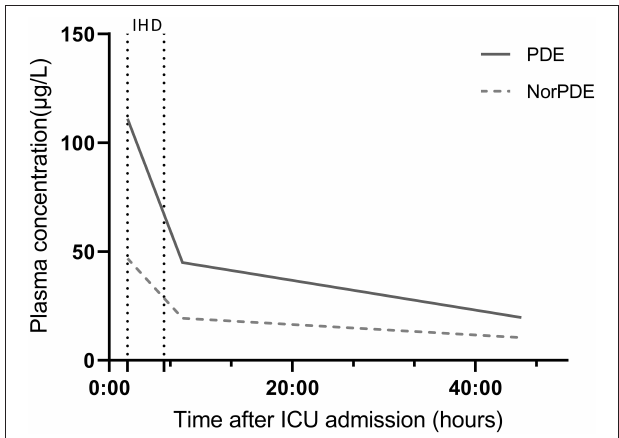
FIGURE 2 | Changes over time in plasma PDE and norPDE concentrations, as measured using high-performance liquid chromatography coupled with tandem mass spectrometry. IHD, intermittent